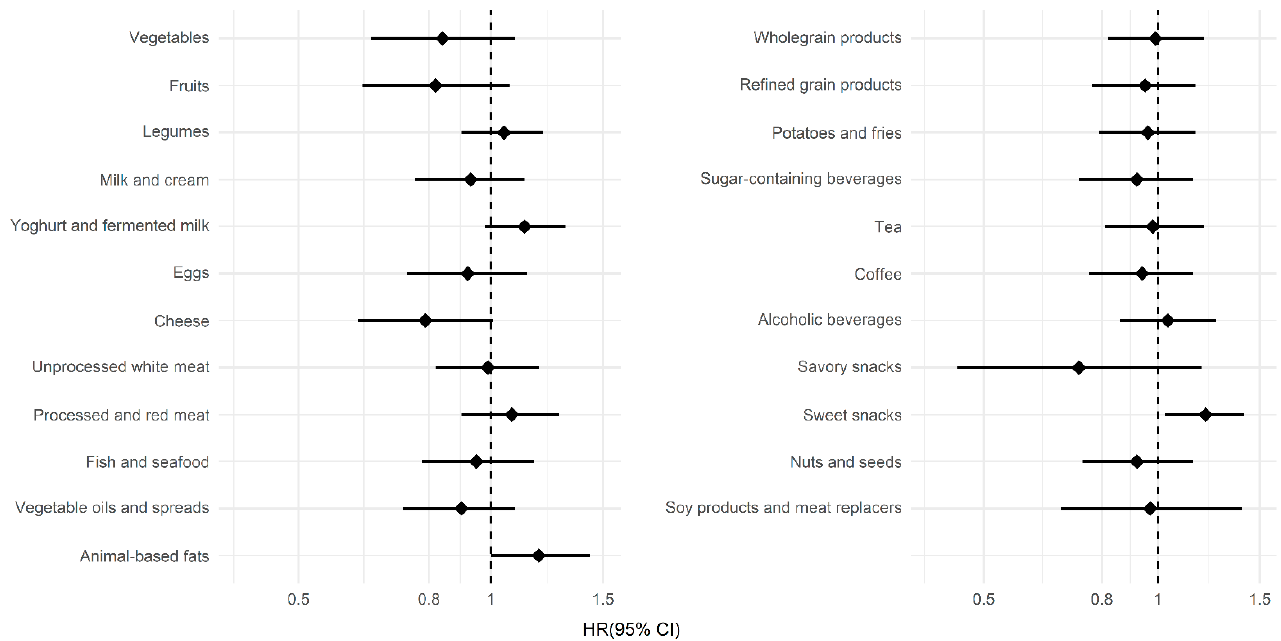
Figure 2. Associations between the food groups and Parkinson’s disease. The hazard ratios (HR), shown as diamonds, and the 95% confidence interval (CI), shown as lines, were obtained using Cox proportional hazard models. Hazard ratios are shown per standard deviation increase in intake for the 23 food groups, which were also used in the principal component analysis.